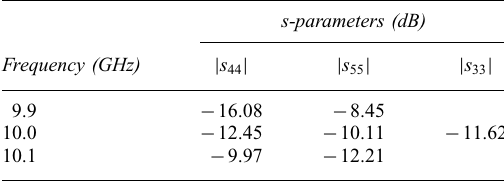
TABLE V Reflection Coefficients at LO and Output Ports of the Active Part of BPSK